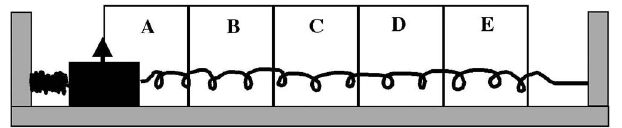
FIG. 4. Histogram of electron frequency on a screen after a simulated two-slit interference experiment. Note similarity to histo- gram representation in Fig. 1.